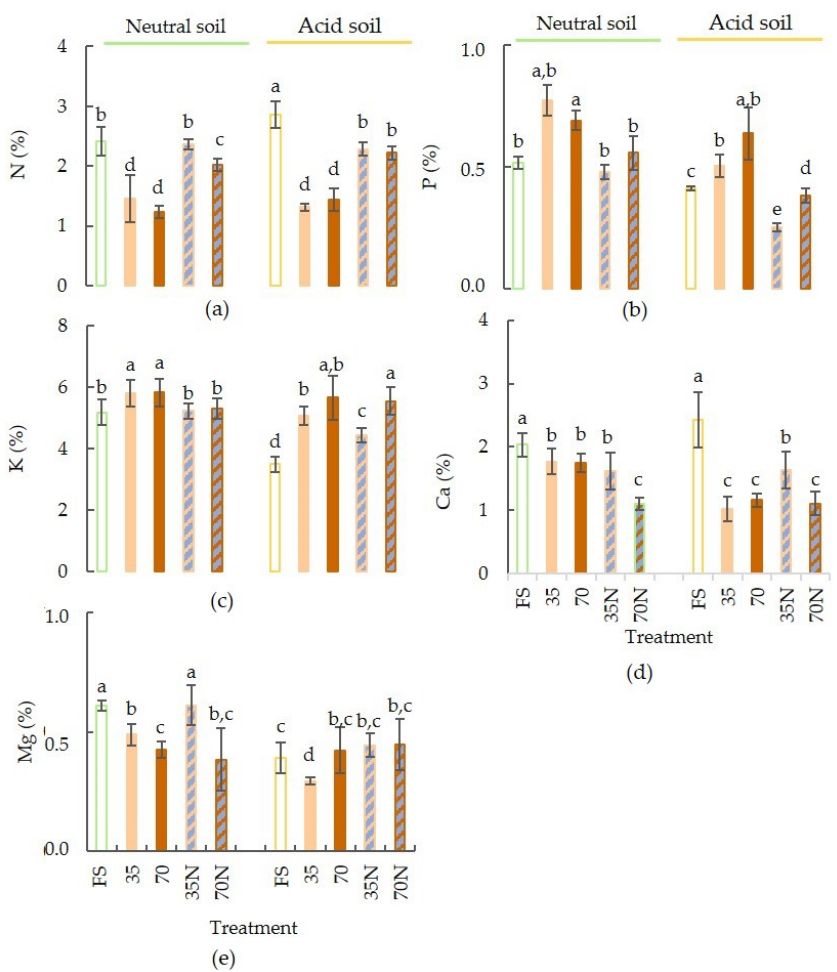
Figure 4. Effects of soil and MSWC supplemented or not with inorganic nitrogen on shoot N ( a ), P( b ), K ( c ), Ca ( d ), and Mg ( e ) concentrations. Note: FS—fertilized soil; 35—35 t MSWC ha − 1 ; 70—70 t MSWC ha-1; 35 + N—35 t MSWC ha − 1 + 92 kg N ha − 1 ; 70 + N—70 t MSWC ha − 1 + 92 kg N ha − 1 . Means with different letters are significantly different at p < 0.05. Each bar represents the mean of six replicates, while the error bars represent ±1SE.